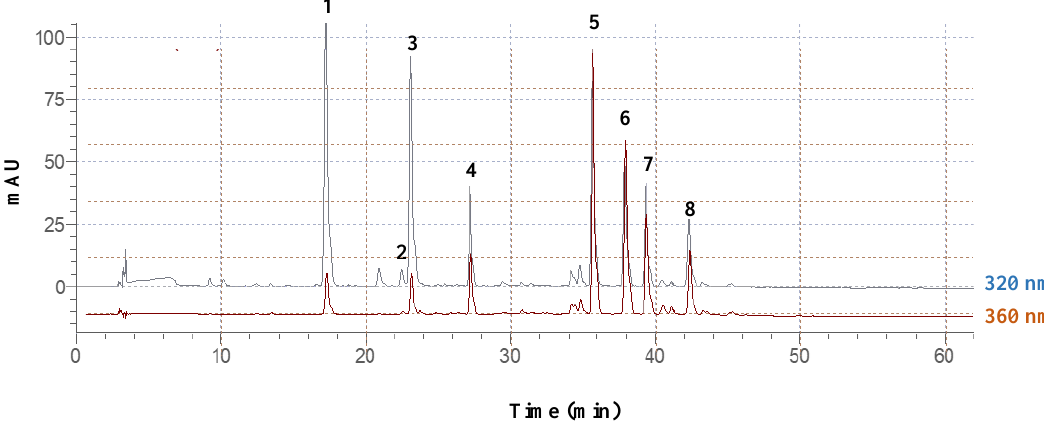
Figure 7. HPLC traces of the sample extracted under optimal conditions, at 80 °C, with ultrasonication pretreatment, recorded at 320 and 360 nm. Peak assignment: 1, neochlorogenic acid; 2, chlorogenic acid; 3, chlorogenic acid isomer; 4, multiflorin B; 5, quercetin glucoside; 6, quercetin manonylglycoside derivative; 7, kaempferol glucoside; 8, kaempferol malonylglucoside.